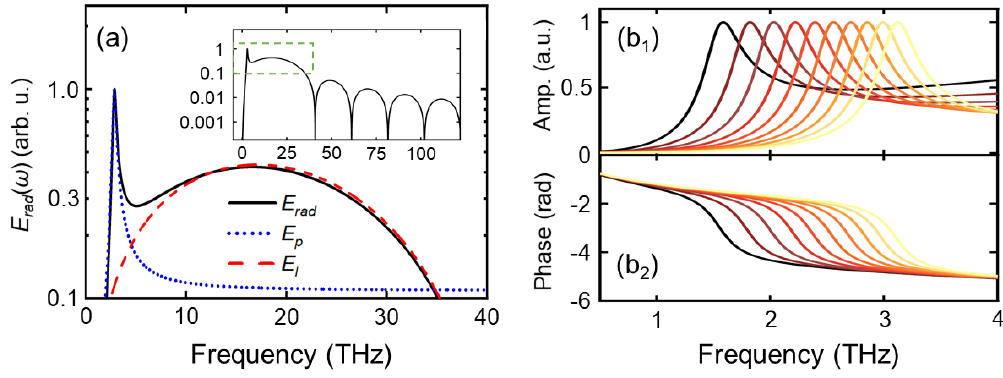
Figure 2: The amplitude and phase spectra of THz radiation given by the res- onance effect. (a) The calculated THz amplitude radiation in frequency domain by Equation (3-5) as the total E ( ω ) (black solid line), low-frequency E ( ω ) (blue rad p dotted line) and high-frequency E ( ω ) (red dashed line), respectively. (a) is enlarged l from the green dashed box in its inset, which is the full view of E ( ω ) along the rad frequency axis. (b ) The amplitude spectrum of the low-frequency peak as a func- 1 tion of THz frequency with an increasing N ranging from 3, 4, 5 ... to 12 × 10 16 cm − 3 e (from left to right). (b ) The corresponding spectral phase 2